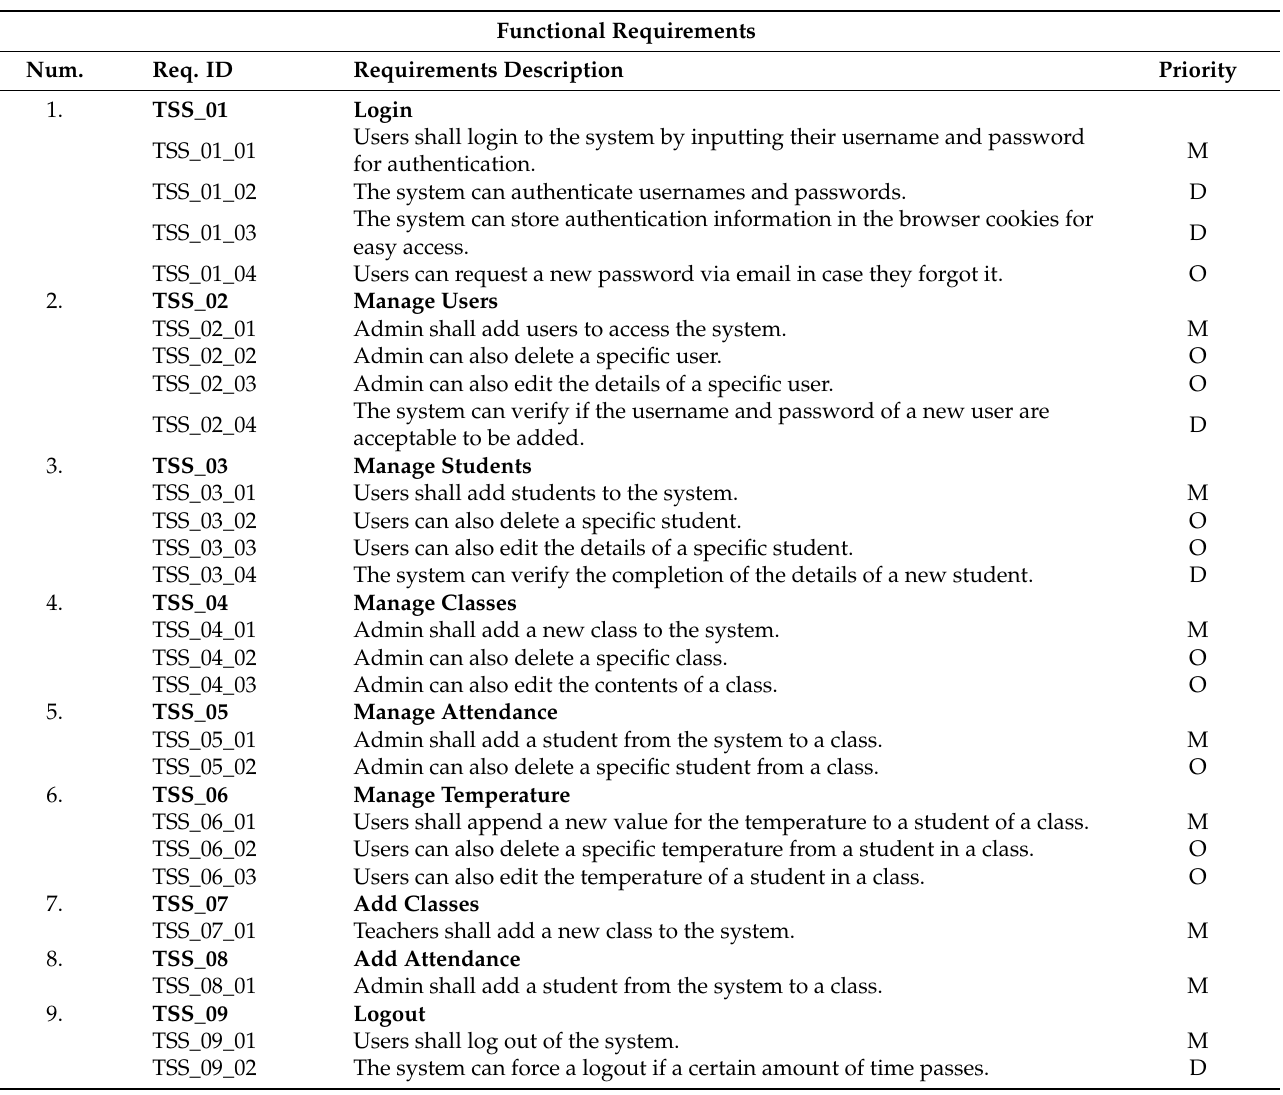
Table 1. List of Requirements for Creating and Managing Attendance and